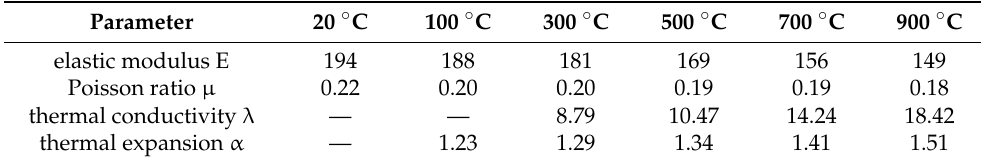
Table 1. Material parameters with different temperature [30].